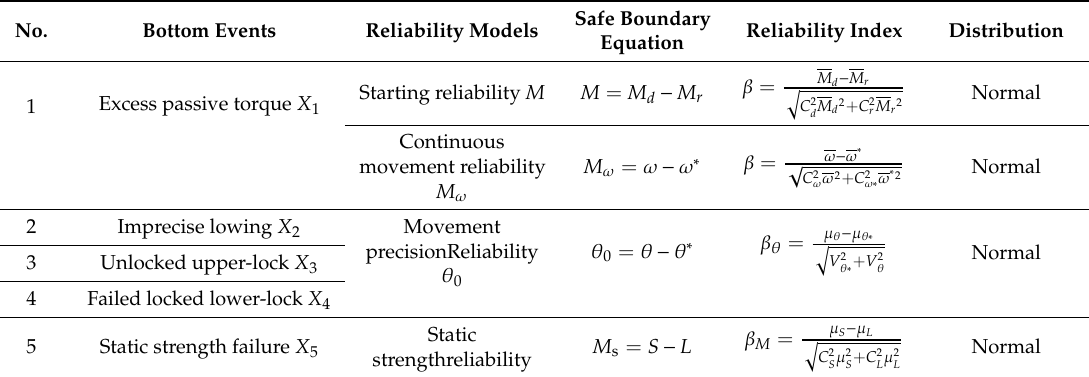
Table 2. Reliability model and distribution of bottom events in fault